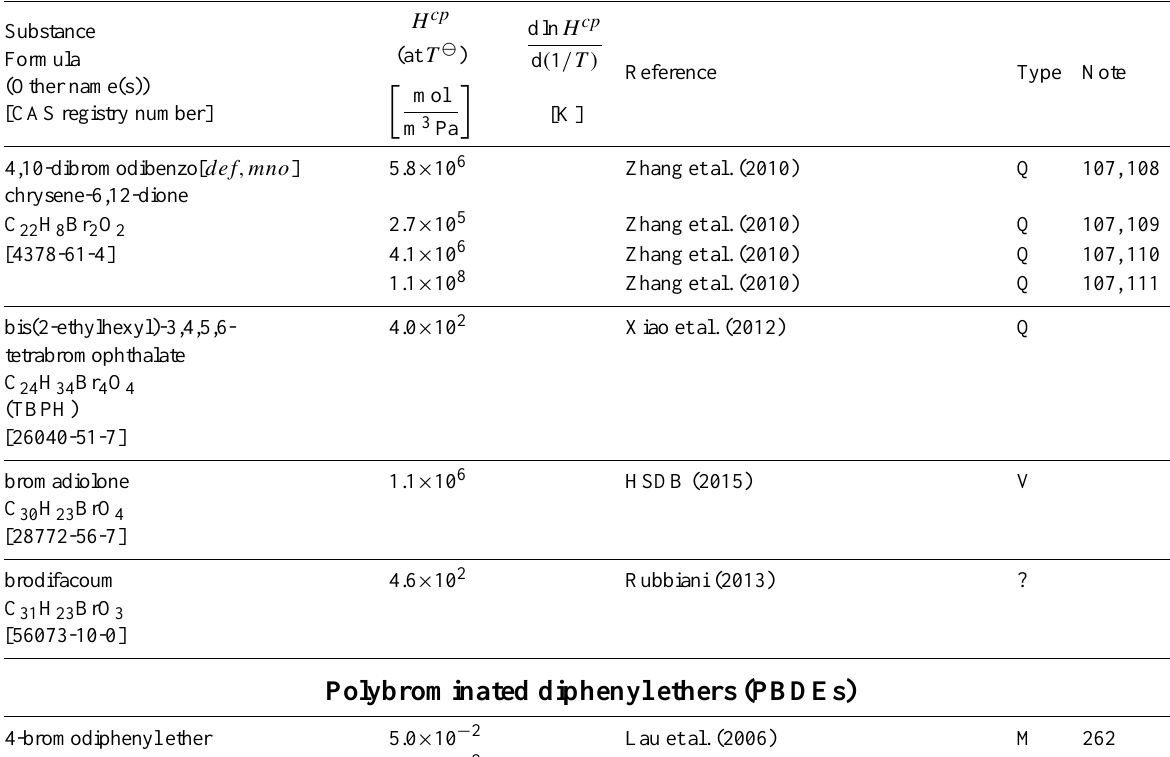
Table 6: Henry’s law constants for water as solvent